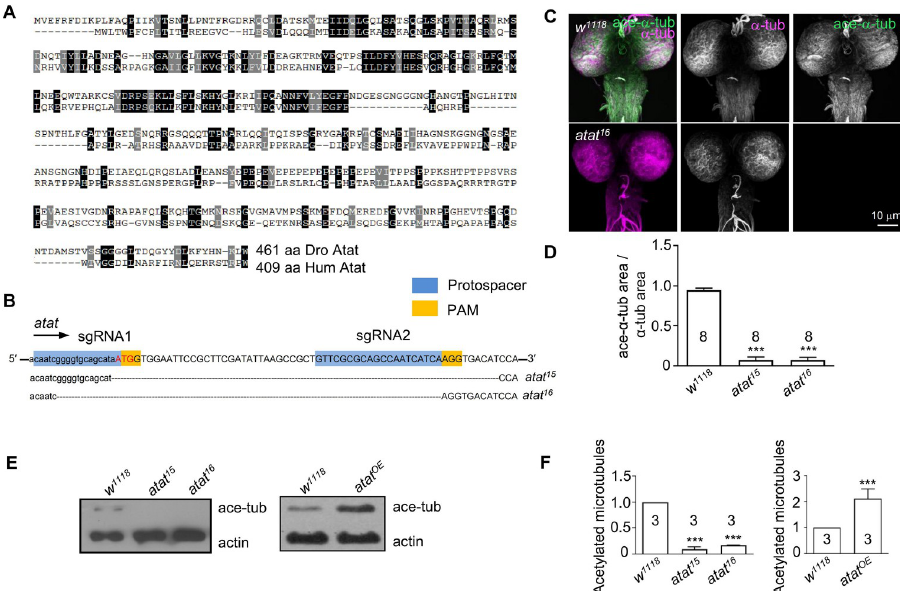
Fig 1. Atat is the major α -tubulin acetyltransferase in the Drosophila nervous system. (A) Sequence alignment of Drosophila Atat (Dro Atat) and human α TAT1 (Hum Atat). Black and gray shading indicate identical (25%) and similar amino acids (40%), respectively. (B) The Cas9/sgRNA-targeting sites were designed to disrupt the coding regions of atat and the sequencing results of the deleted regions in two atat mutants. The atat UTR sequence is presented in lowercase and the start codon is presented in red uppercase. The atat coding sequence is presented in uppercase. (C) The larval nervous systems of control ( w 1118 ) and atat 16 mutants are double-labeled with anti- α -tubulin (green) and anti-acetylated tubulin (magenta). Scale bar: 10 μ m. (D) Normalized acetylated microtubule density in wildtype control and two atat mutants. Mean ± SEM. One-way ANOVA with Tukey’s multiple comparisons test. ��� p < 0.001. (E) Western analysis of acetylated α -tubulin in the larval nervous system in control ( w 1118 ), atat mutants, and larvae with Atat overexpressed using elav-Gal4 ( atat OE ). Actin was used as a loading control. (F) Normalized intensities of acetylated microtubules. Mean ± SEM. One-way ANOVA with Tukey’s multiple comparisons test. ��� p <